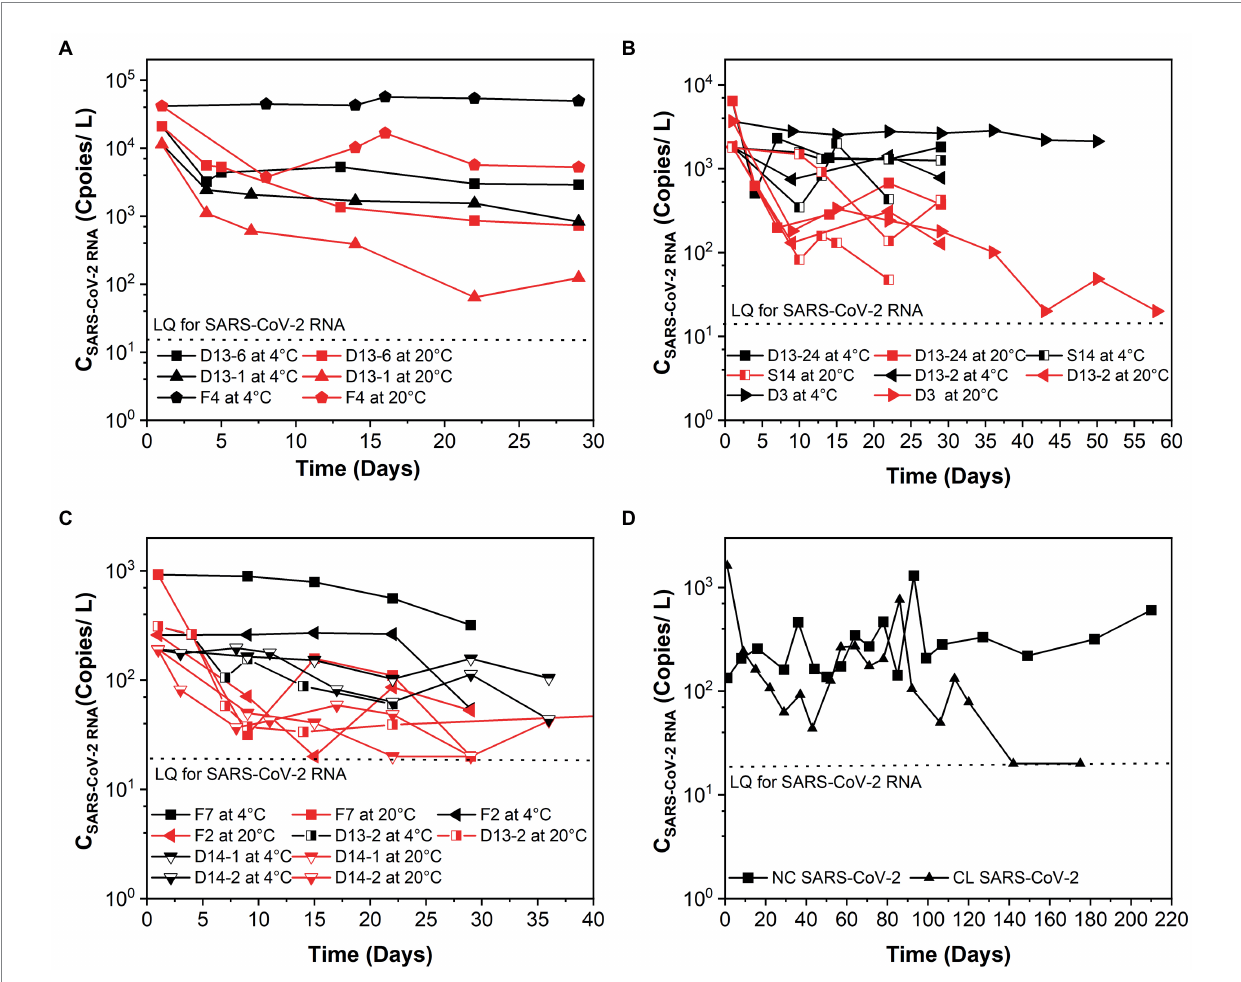
FIGURE 1 Persistence of SARS-CoV-2 over time (days) in raw sewage from university dormitories. (A) High-concentration level of SARS-CoV-2 (C SARS-CoV-2 RNA > 10 4 copies/L), (B) Medium-concentration level of SARS-CoV-2 (10 4 copies/L > C SARS-CoV-2 RNA > 10 3 copies/L), (C) Low-concentration level of SARS-CoV-2 (10 3 copies/L > C SARS-CoV-2 RNA > 10 2 copies/L), (D) Long time decay of SARS-CoV-2 at 4 ° C. LQ means the limit of quantification in RT-qPCR. F4, D13-6, D13-1, D13-24-1, D3, S14, D13-2-1, D13-24-2, S12-1, F7, S12-2, D13-2-2, F2, D14-1, D14-2, NC, and CL correspond to different campus